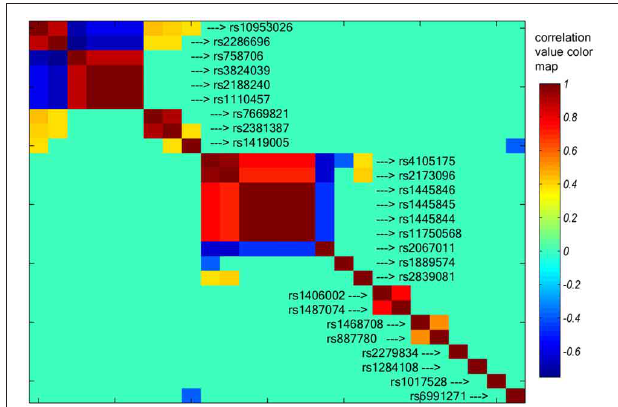
FIGURE 2 | Cross-correlation among the top 26 SNP loci. All correlations stronger than 0.35 were plotted ( p < 0 . 001). Two big clusters were identified; one is centered at chromosome 7q21, including rs10953026 and rs2188240. The other is centered at chromosome 5q35 including rs4105175 and rs1445846. See text for the detail list of SNPs.